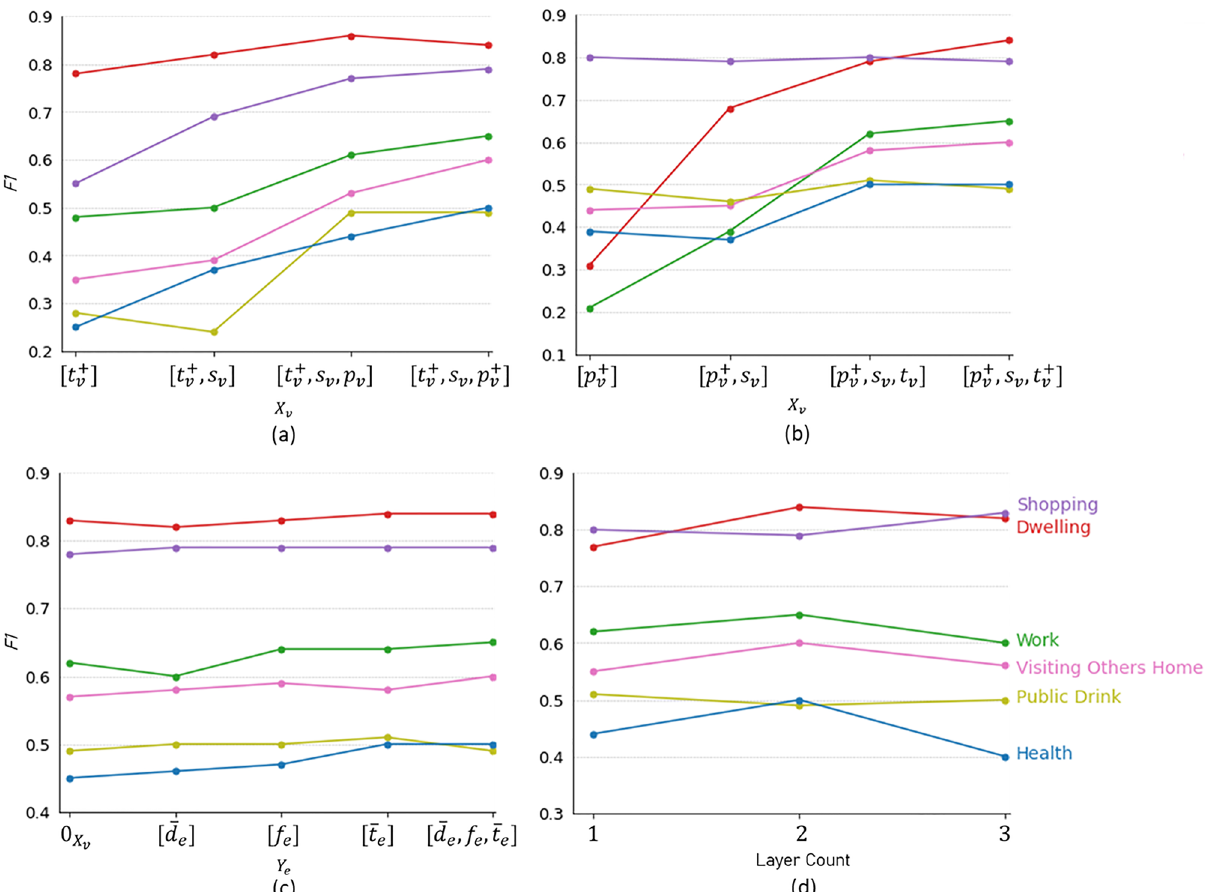
Figure 5. Impact of node features ( X v ): ( a ) POI representations, and ( b ) temporal representations; ( c ) edge weights ( Y e ); and ( d ) hidden layer counts ( N L ) on F 1 score for identifying six distinct travel activity